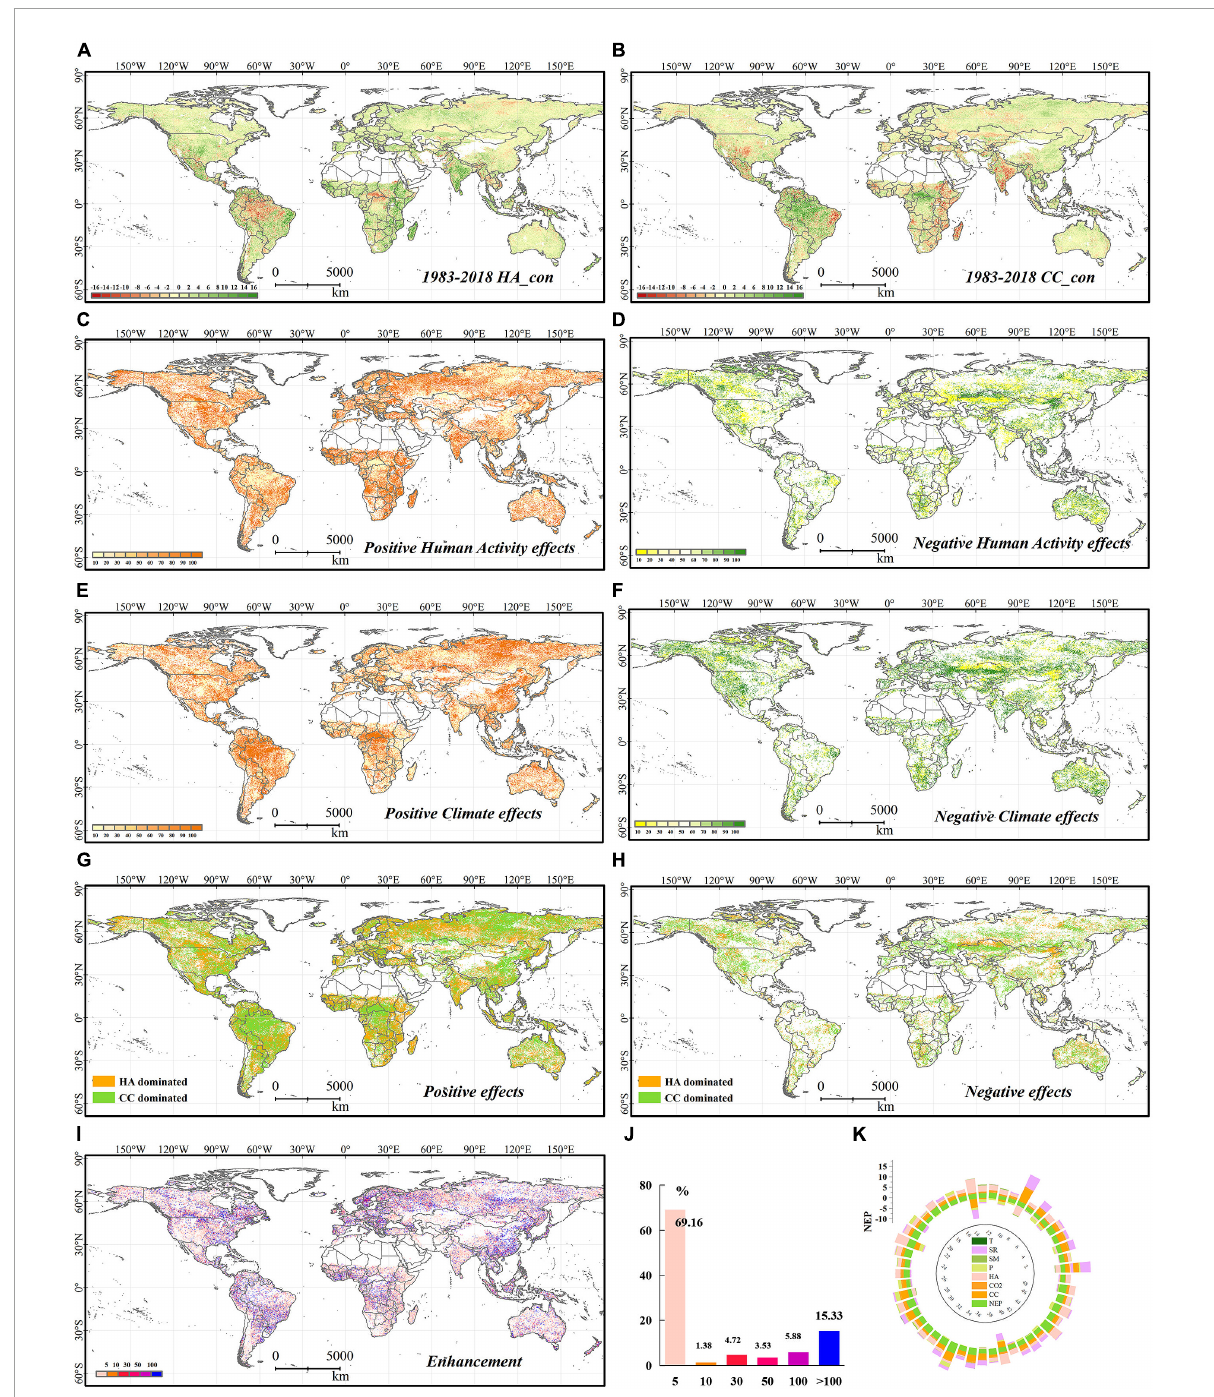
FIGURE5 The HA_con (A) and the CC_con (B) to NEP, the CC_con and HA_con to NEP increasing (C,E) and decreasing (D,F) ; spatial pattern of the CC and HA controlled the increasing (G) and decreasing (H) of the NEP; spatial diagram of the positive of CC_con to HA_con (I) ; the proportions that CC enhances the HA_con (J) ; the trend of NEP in the top 50 countries of global (K)